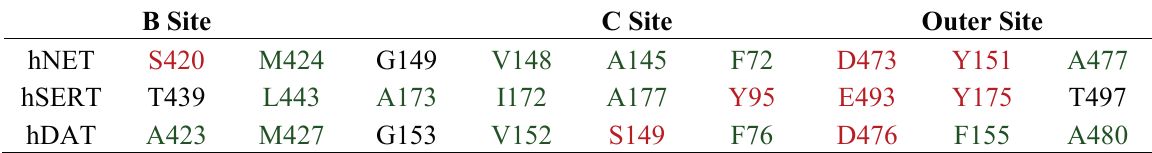
Figure 3. Chemical structure of nortriptyline (co-crystallized ligand from the template, PDB code 4M48) [28]. Table 1. Sequence alignment of all distinct monoamine transporter residues located in sub sites (reference [32]) in the vicinity of the docked compounds. Red: hydrophilic side chain, green: lipophilic side chain, bold: bulkier side